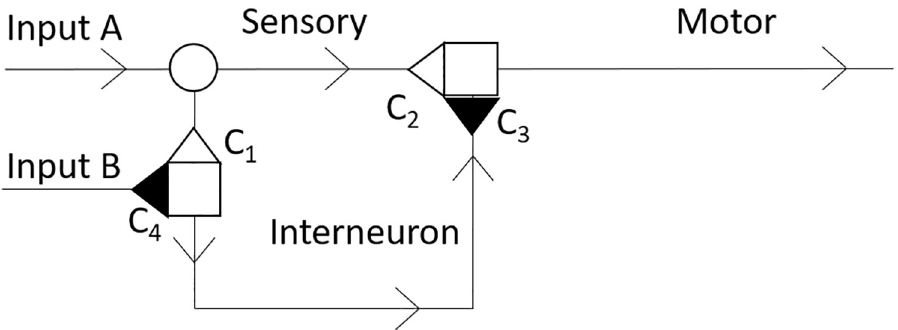
Fig 1. Schematic diagram which illustrates the composition of the RDMU with two stimulating inputs A and B. Excitatory synapses C 1 and C 2 are shown as empty triangles. Inhibitory synapses C 3 and C 4 are represented by filled-in triangles. Synaptic junctions are denoted by empty squares and the neuronal branching point is marked with an empty circle. Arrows represent the direction of propagation of transmembrane potentials. The portion of the RDMU between C 1 and C 3 is the interneuron.